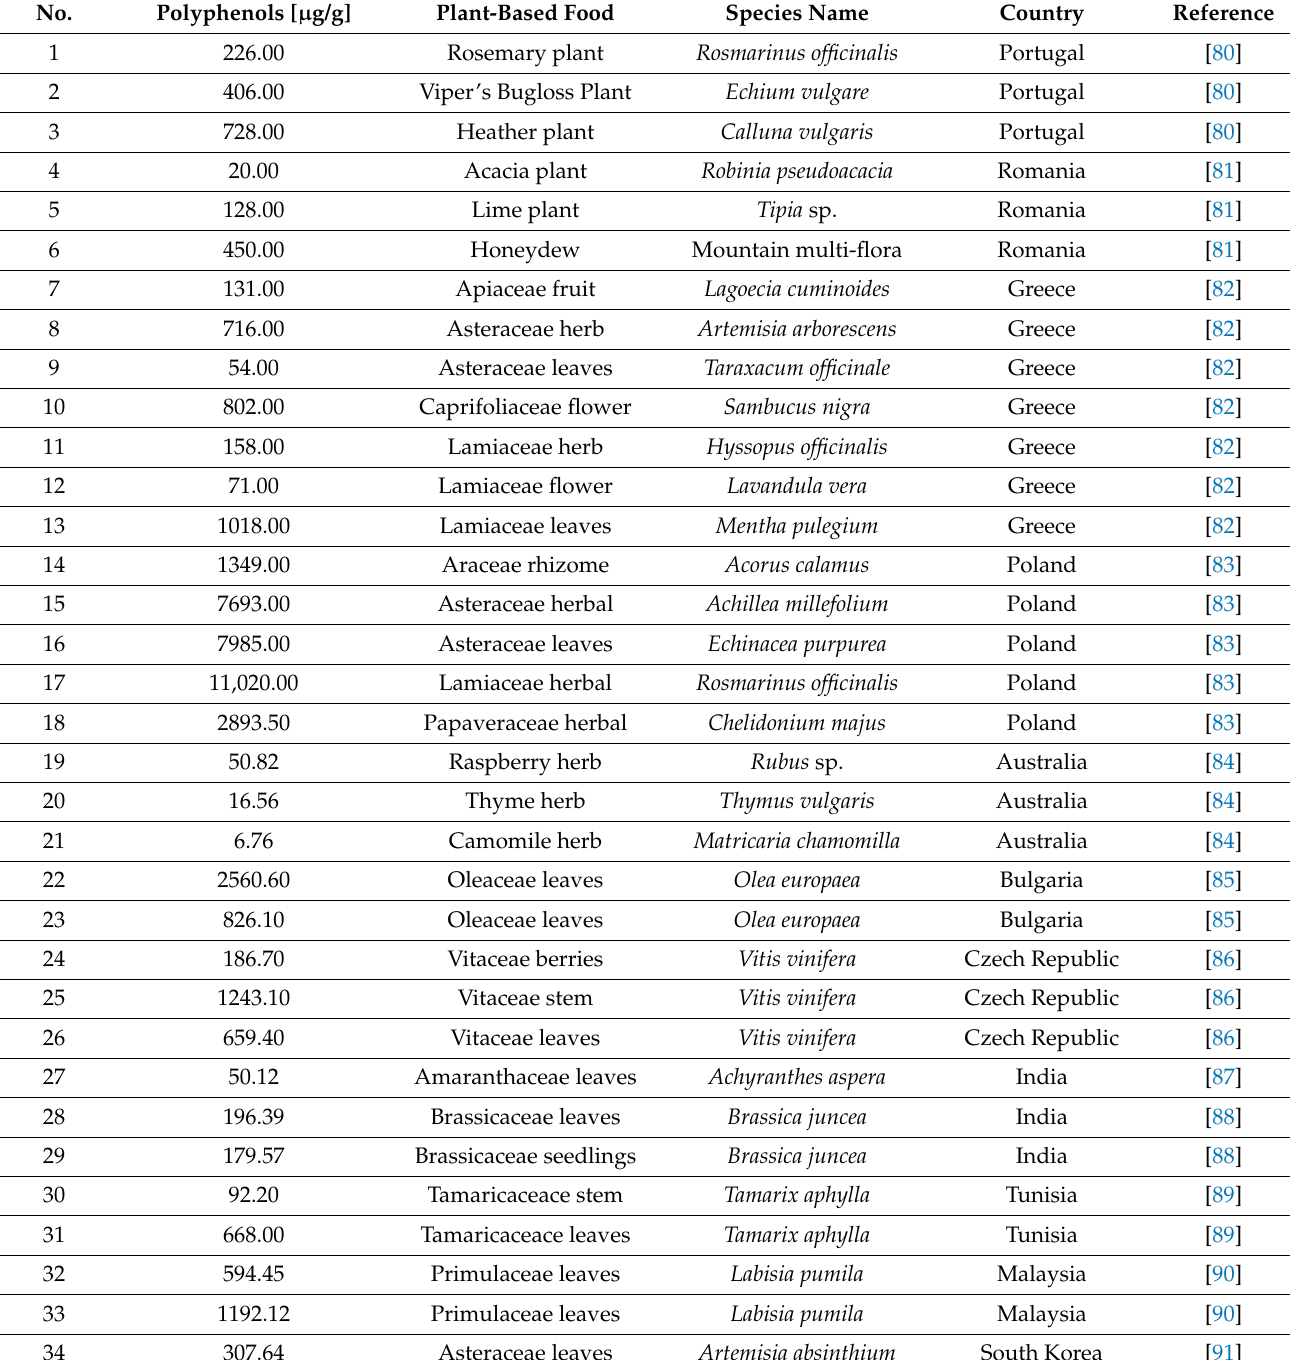
Table 1 illustrates various countries revealing their polyphenol composition based on plant-based products. According to these data, the polyphenol content varies widely, from ~7 to over 11,000 µ g/g, depending on the species and the country. Table 1. Polyphenol composition in various